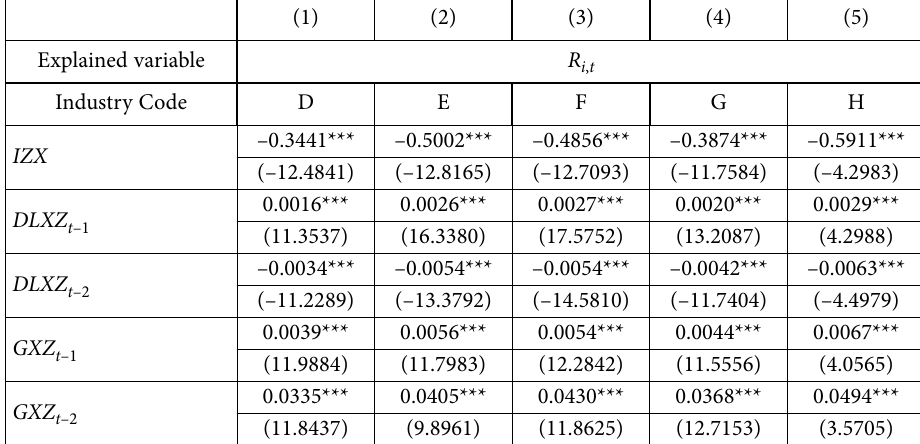
Table 5. Impact of infodemic on stock market